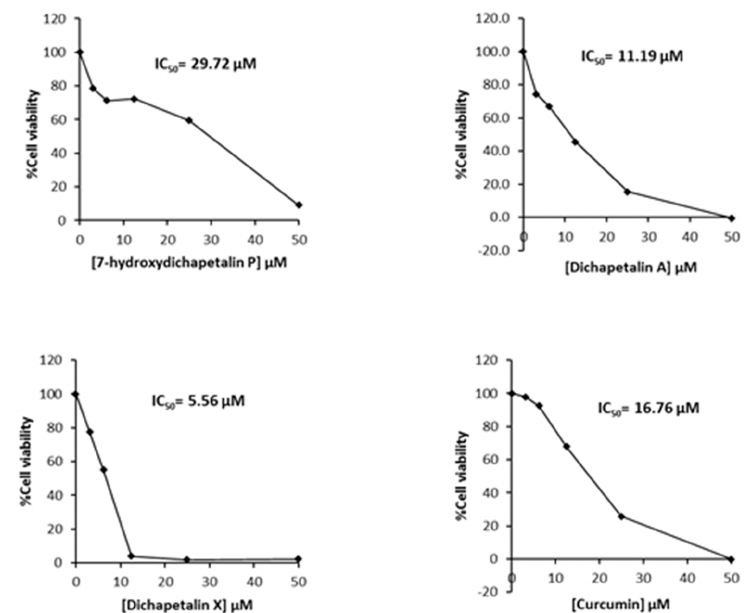
Figure 5. Cytotoxic effect of compounds 1 – 3 and curcumin on HL-60 cell viability.